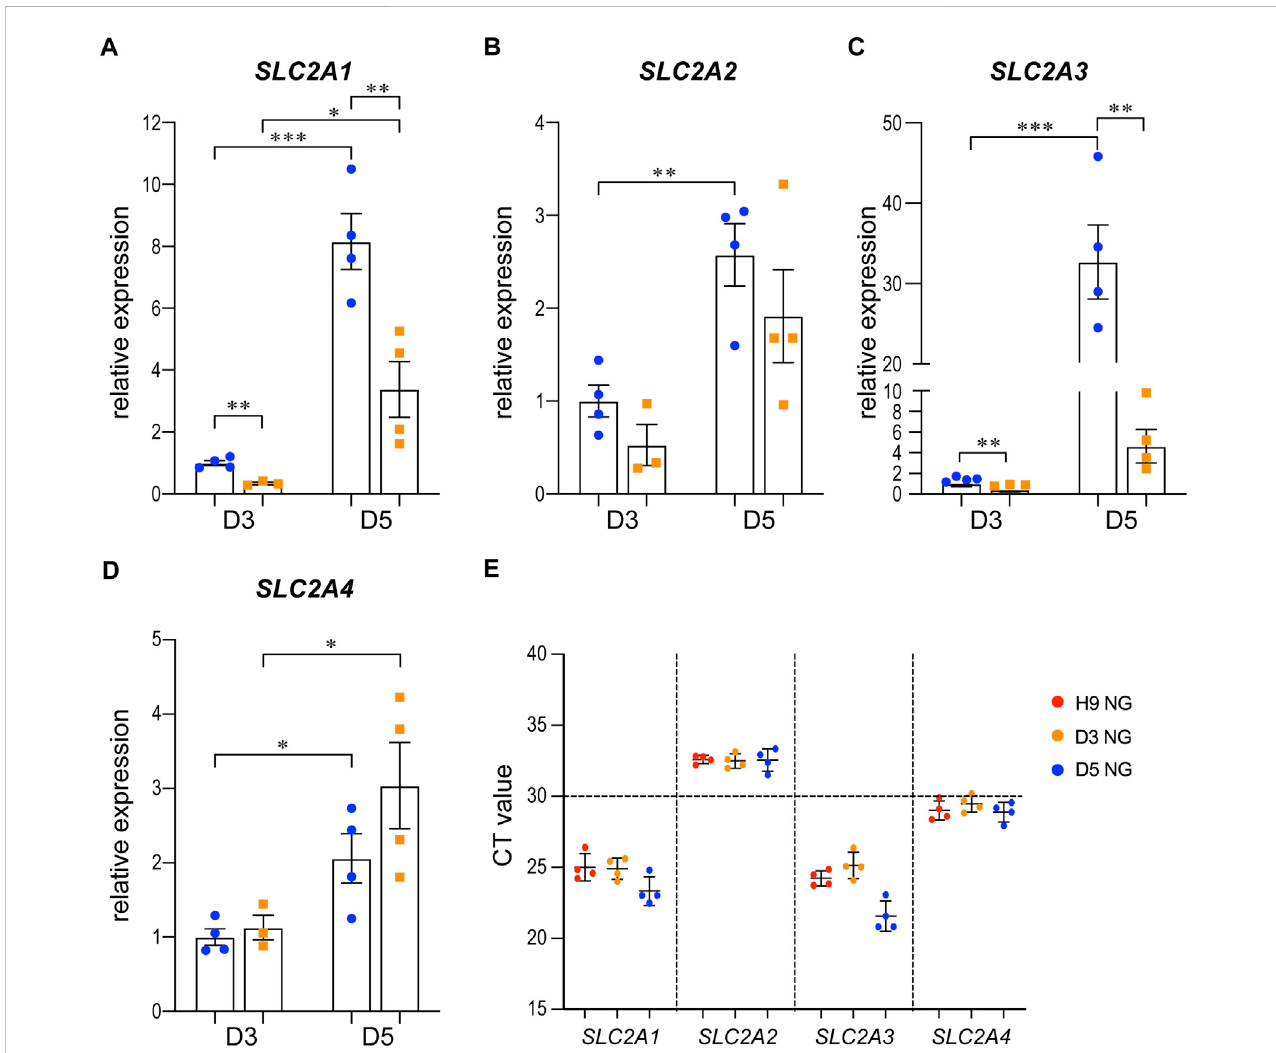
FIGURE 6 The expression changes of SLC2A1-4 in control and high glucose groups of the 3D models at D3 and D5.3D neuroepithelial cysts were grown in either normal glucose (NG) or 2x high glucose (HG) conditions. Cysts were collected at either D3 or D5. Total RNA was extracted and subjected for qRT-PCR. N ≥ 3 wells/condition. The relative expression level of each gene was calculated to compare to the expression level in NG group at D3. The results for SLC2A1-4 were presented in (A – D) respectively. The CT values of qRT-PCR for these four genes in the H9 cells and cysts at either D3 or D5 from the NG groups were shown in (E)